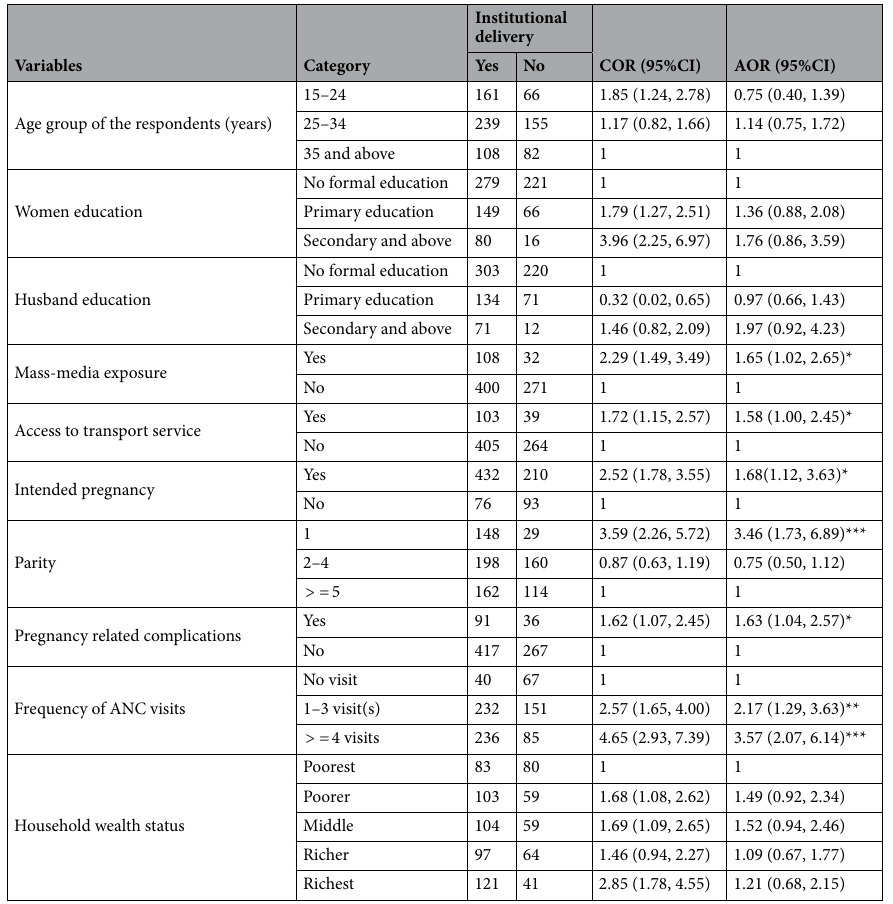
Table 5. Factors affecting institutional delivery in a rural Northwest Ethiopia, 2020. *Significant at p < 0.05; **significant at p < 0.01; ***significant at p <